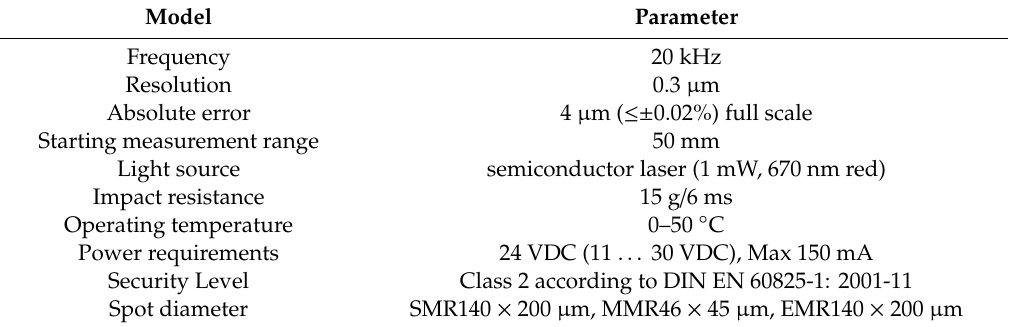
Table 1. Laser displacement sensor parameters.